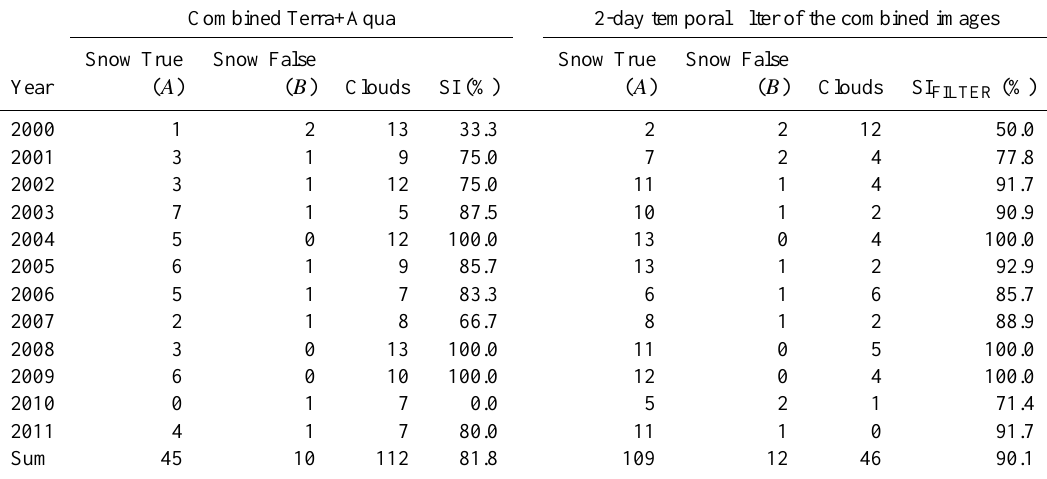
Table 5. Snow mapping accuracy (SI) at ˇCervenec station. The A , B and Clouds categories represent the number of station days and are defined as in Table